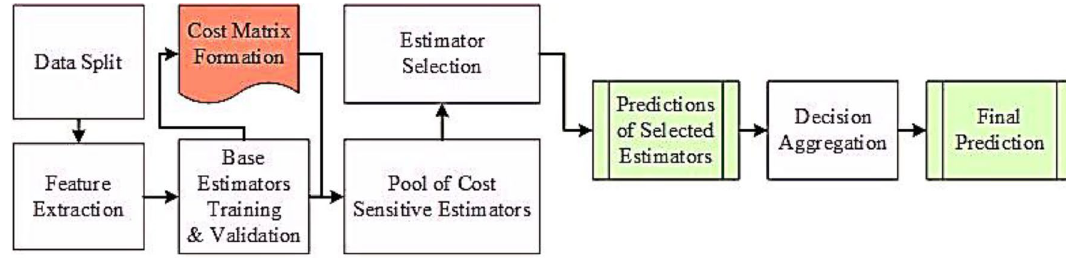
Figure 1. Abstract diagram of the proposed CSPE-R